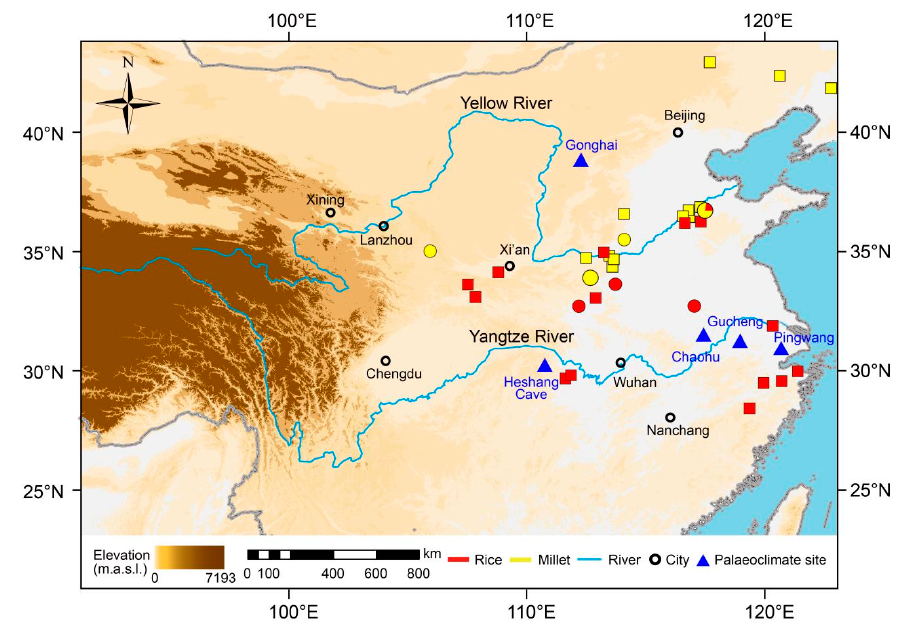
Figure 1. The spatial pattern of crop macro-fossils from sites dated between 9000–7000 BP in China. Squares represent sites without detailed archaeobotanical data; circles represent sites with detailed archaeobotanical data.